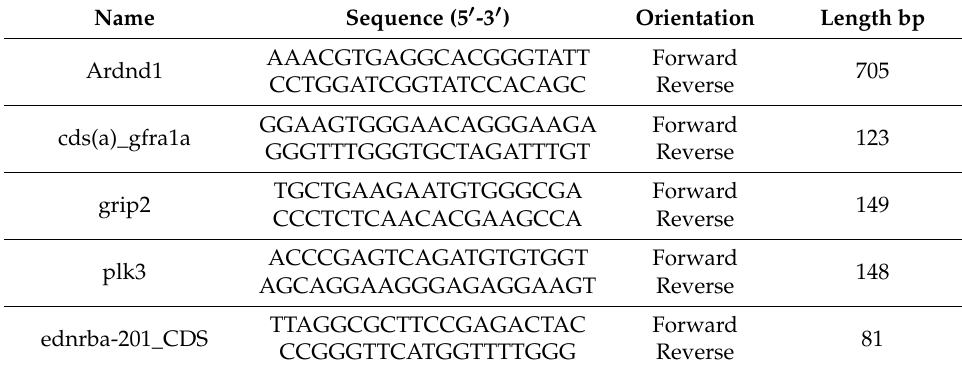
Table 1. Quantitative polymerase chain reaction (PCR) primer sequences for germ-line specific genes ( dead end , gfra1a , grip2 , plk3 and ednrba